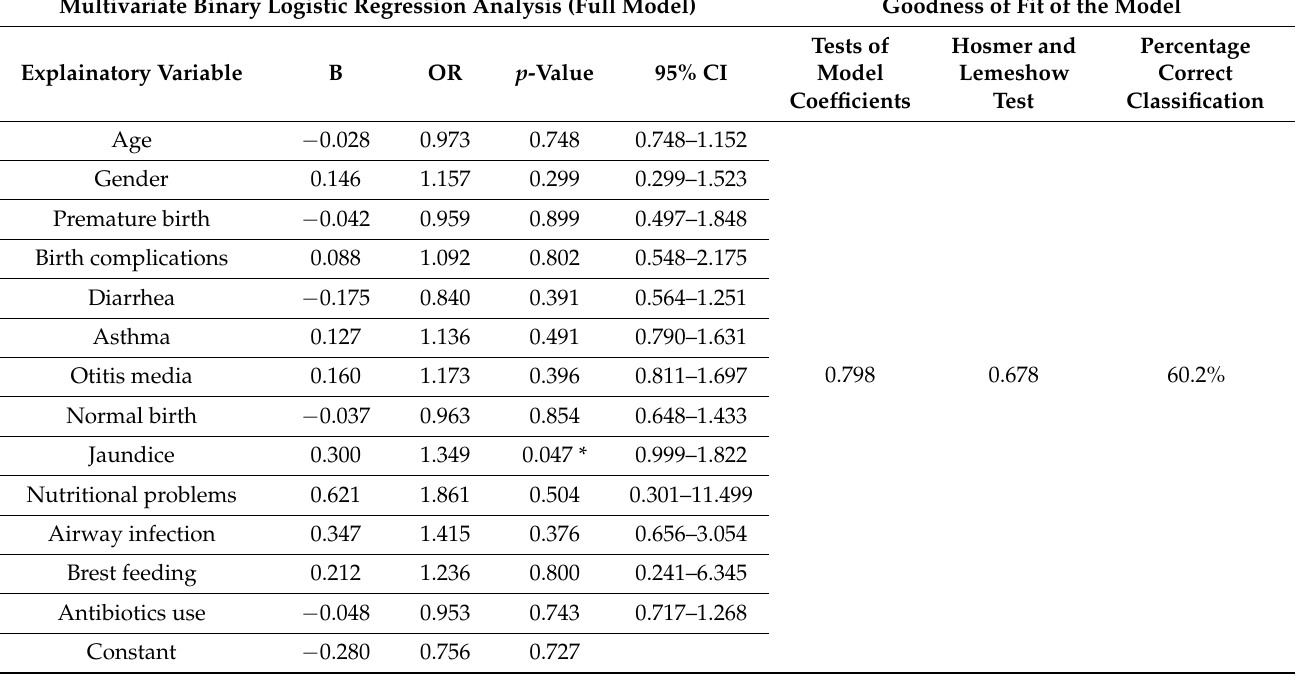
Table 4. Multivariate binary logistic regression of etiological factors for MIH. Multivariate Binary Logistic Regression Analysis (Full Model)